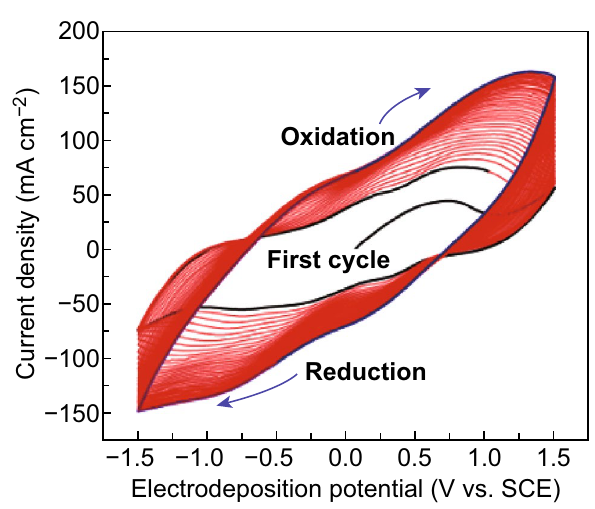
Fig. 2 CV curves of the deposition of mixed‑valence vanadium oxide